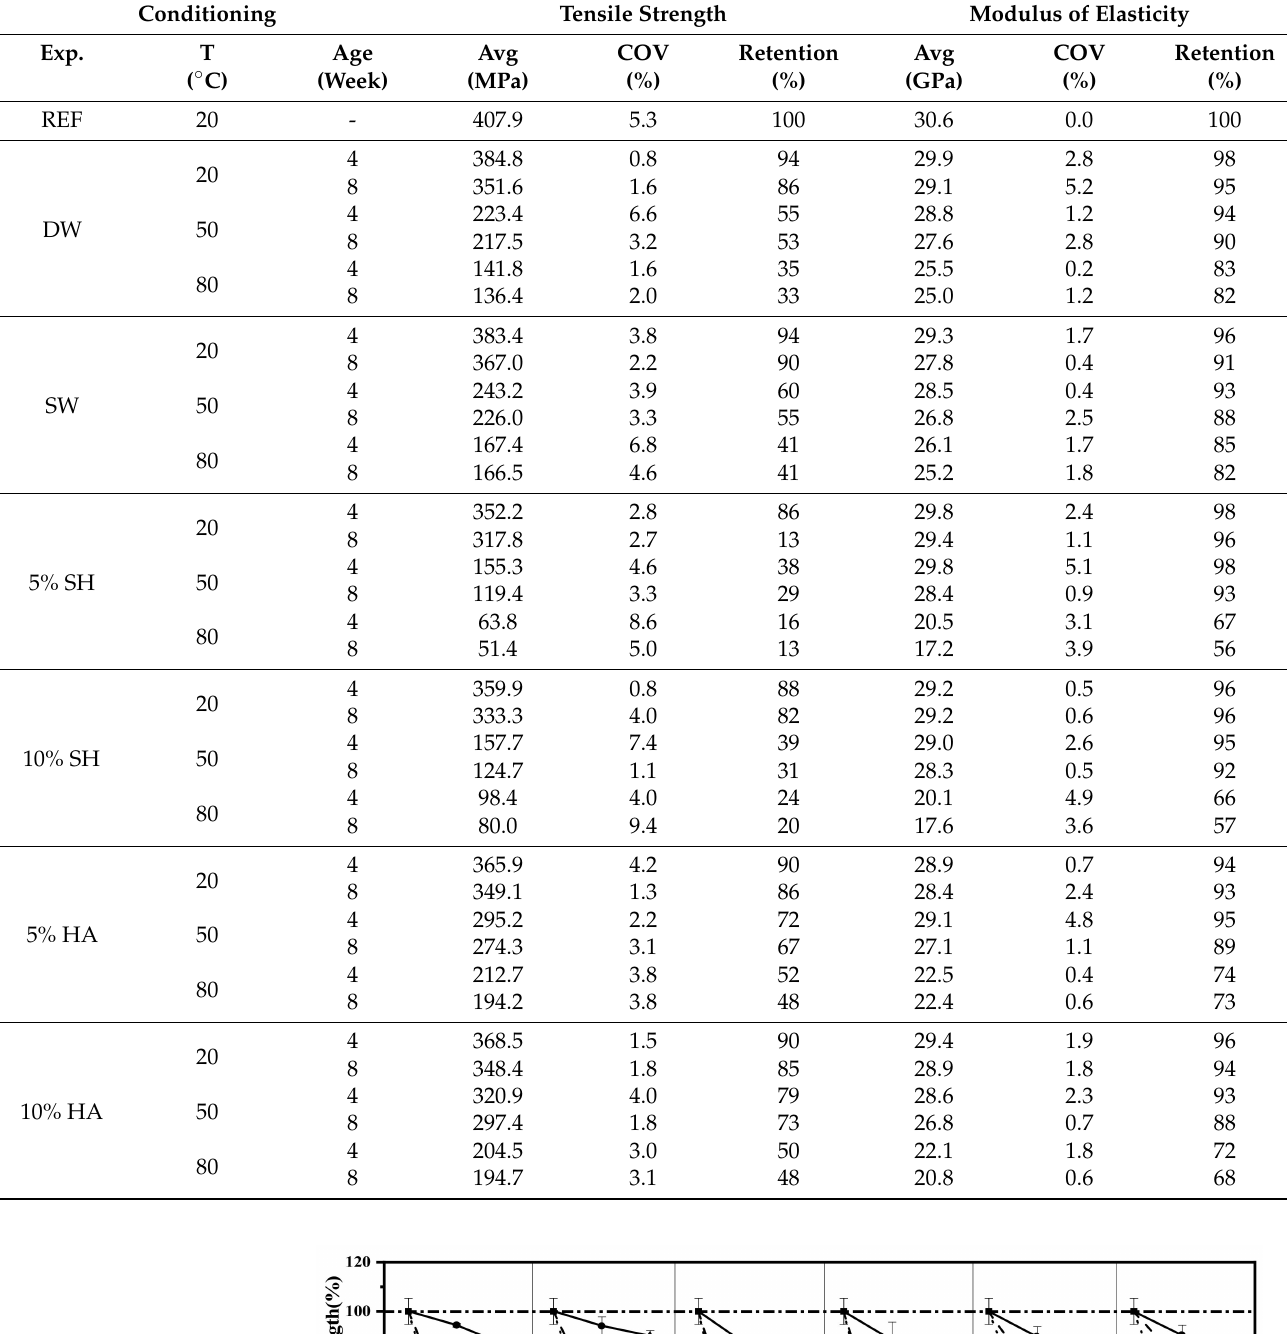
Table 2. Summary of mechanical test results.